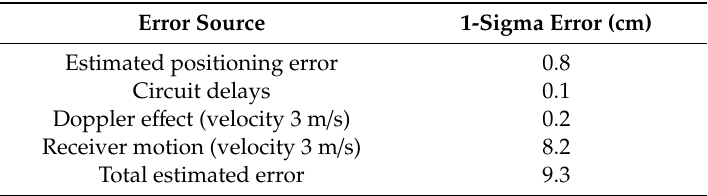
Table 5. Error budgeting.